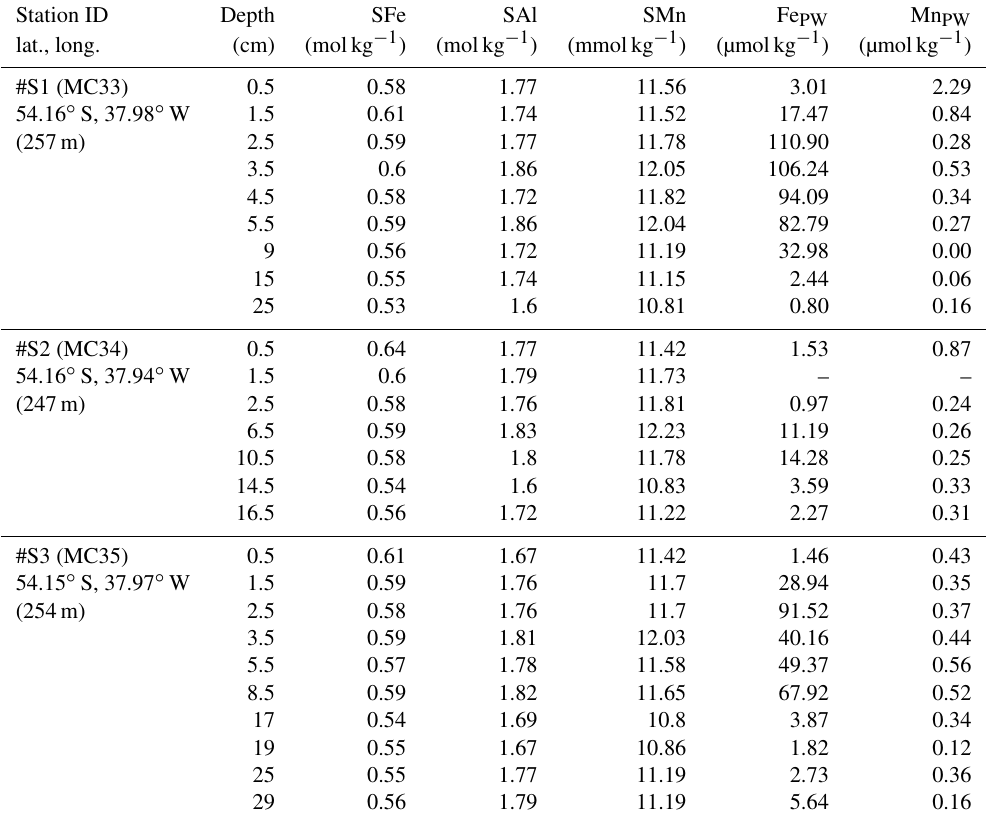
Table 4. Sediment core samples: particulate iron (SFe), aluminum (SAl), and manganese (SMn) concentrations in shelf sediments collected during JC055 in January and February 2011. Pore water data retrieved additionally from these three cores are listed for Fe (Fe PW ) and Mn (Mn PW ). Additional information are event number (MC...), latitude and longitude, and water column depth. Station